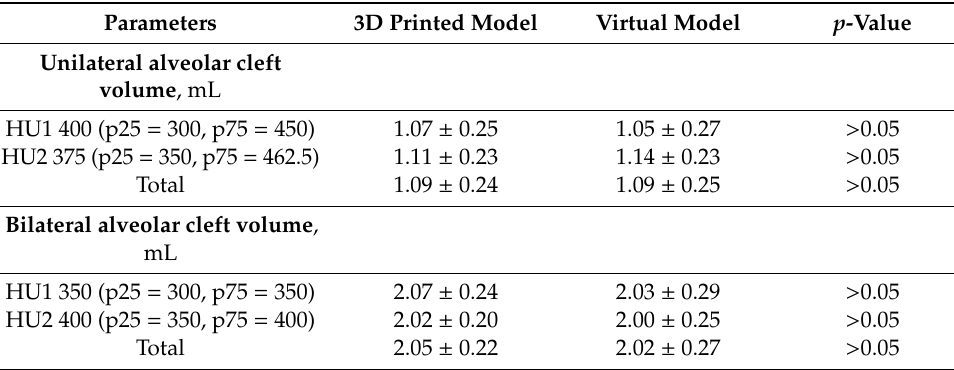
Table 1. 3D imaging-based volume of unilateral and bilateral alveolar cleft defects by printed and virtual